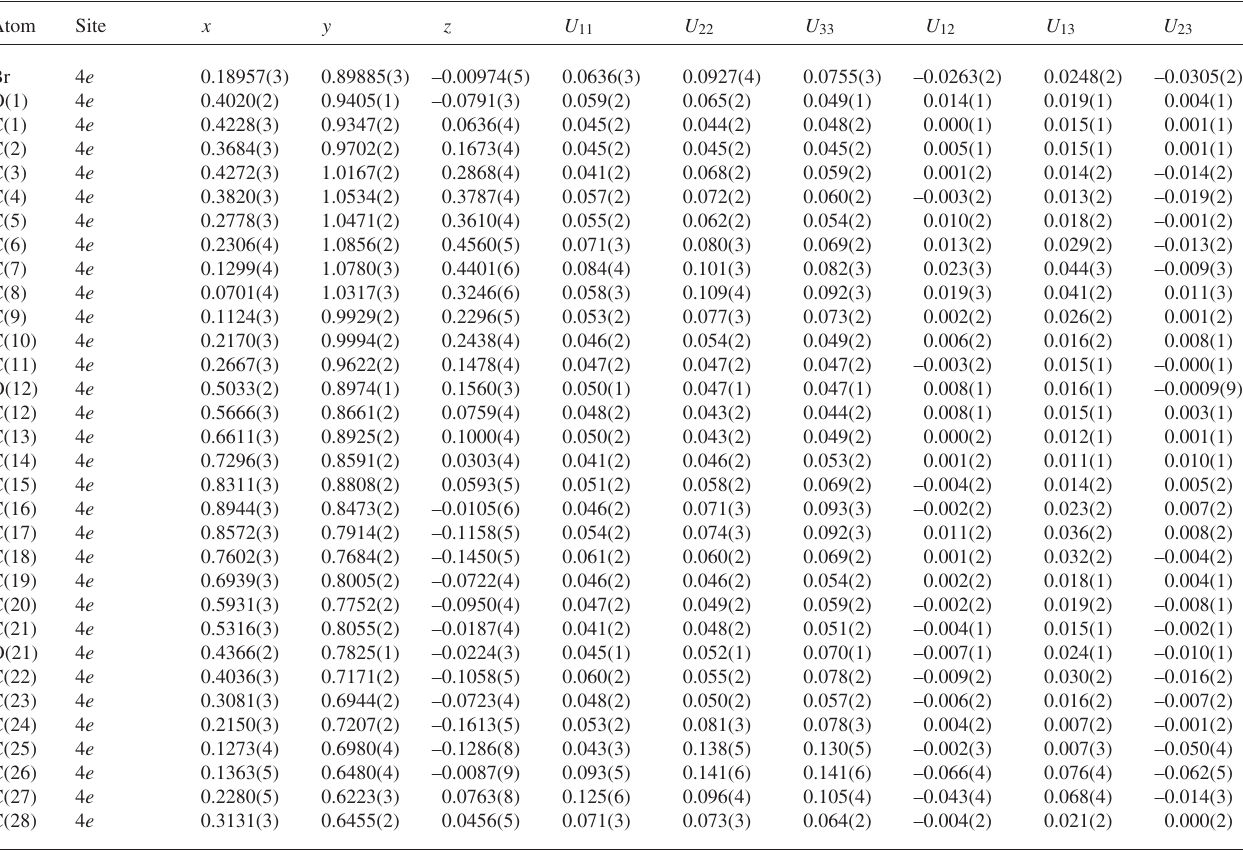
Table 3. Atomic coordinates and displacement parameters (in Å 2 )